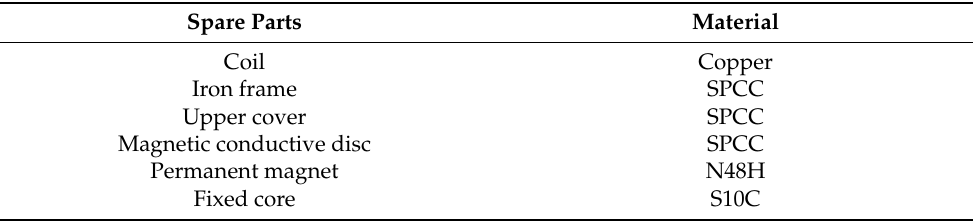
Table 8. Materials of parts in simulation